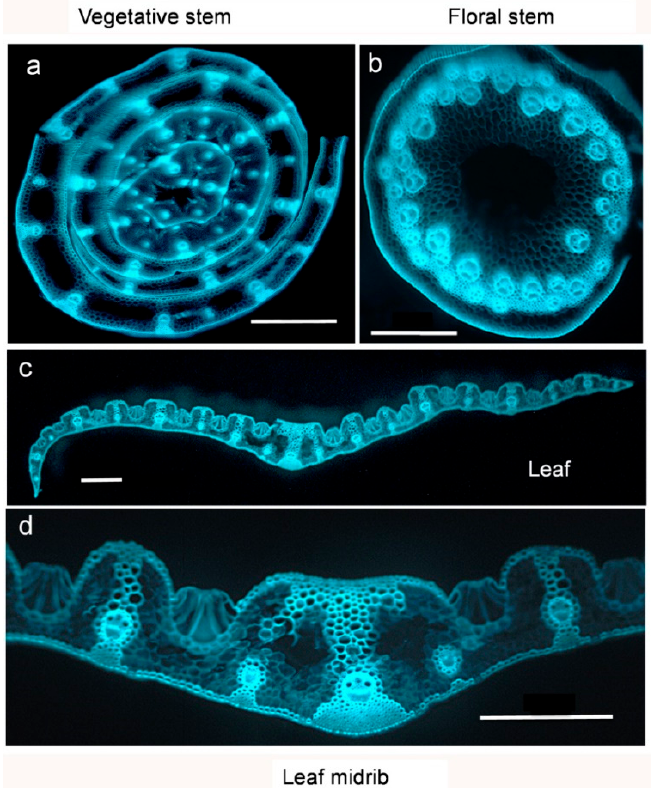
Figure 4. Autofluorescence of cell wall phenolics in Festuca arundinacea. Transverse sections of vegetative ( a ) and floral ( b ) stems and whole leaf ( c ) and leaf midrib ( d ) of Festuca arundinacea photographed under UV light in 0.01 M NaOH, showing blue fluorescence of cell wall phenolics. Bar = ~500 µm. Unpublished original data. Source P. Morris.